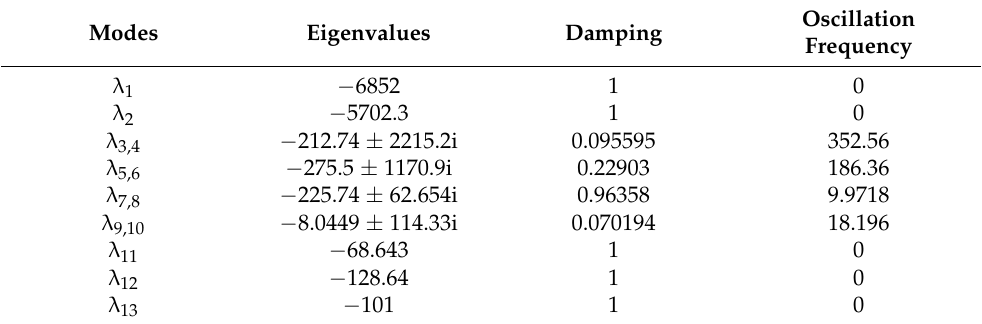
Table 2. Eigenvalues, damping and oscillation frequency of the system at steady-state